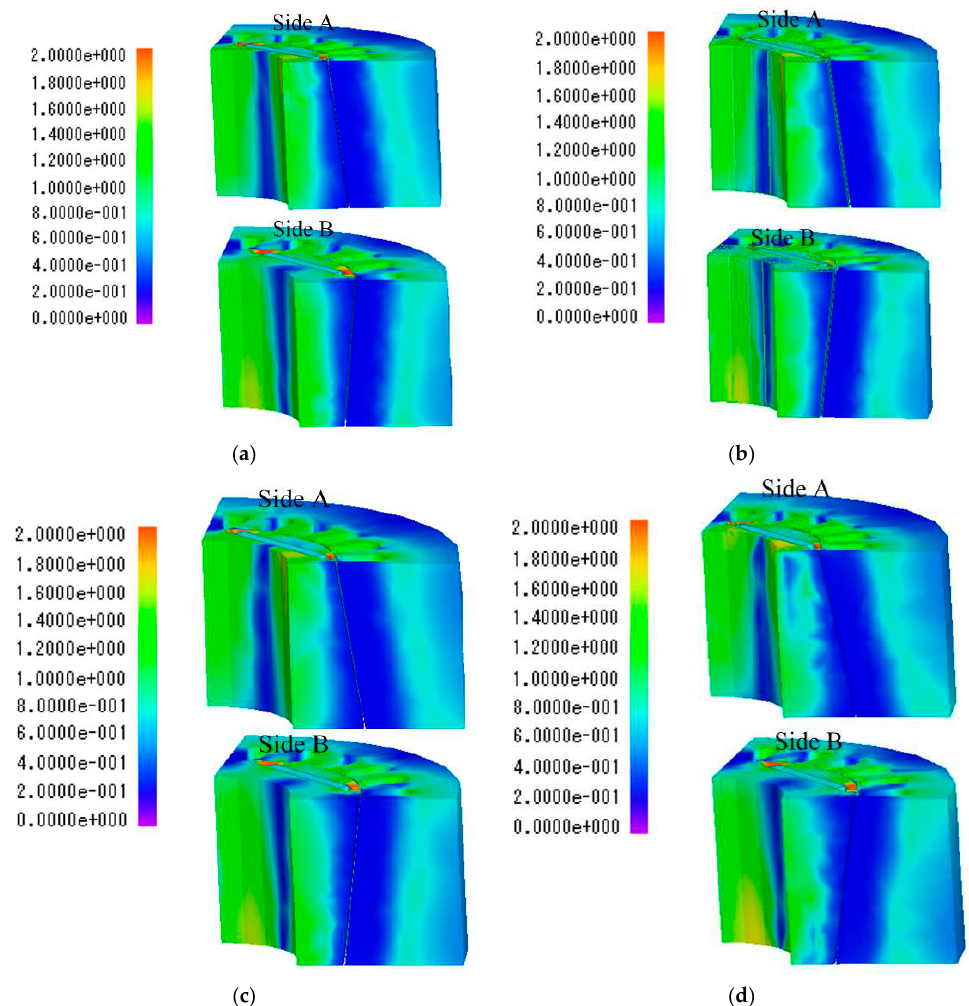
Figure 6. 3-D FE results at different cone angle: ( a ) Flux density at α = 2°, ( b ) Flux density at α = 4°, ( c ) Flux density at α = 6°, ( d ) Flux density at α = 8°.